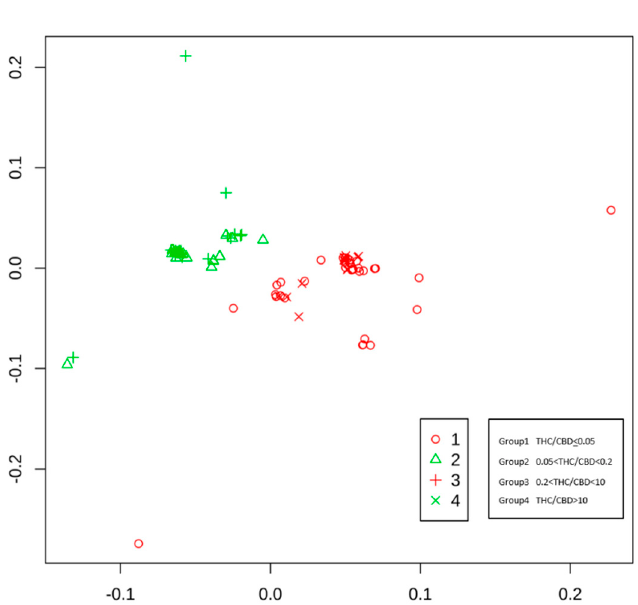
Figure 2. Biplot of cannabis samples with different symbols for each variety group and different colors for fiber-type and cannabis-type samples.